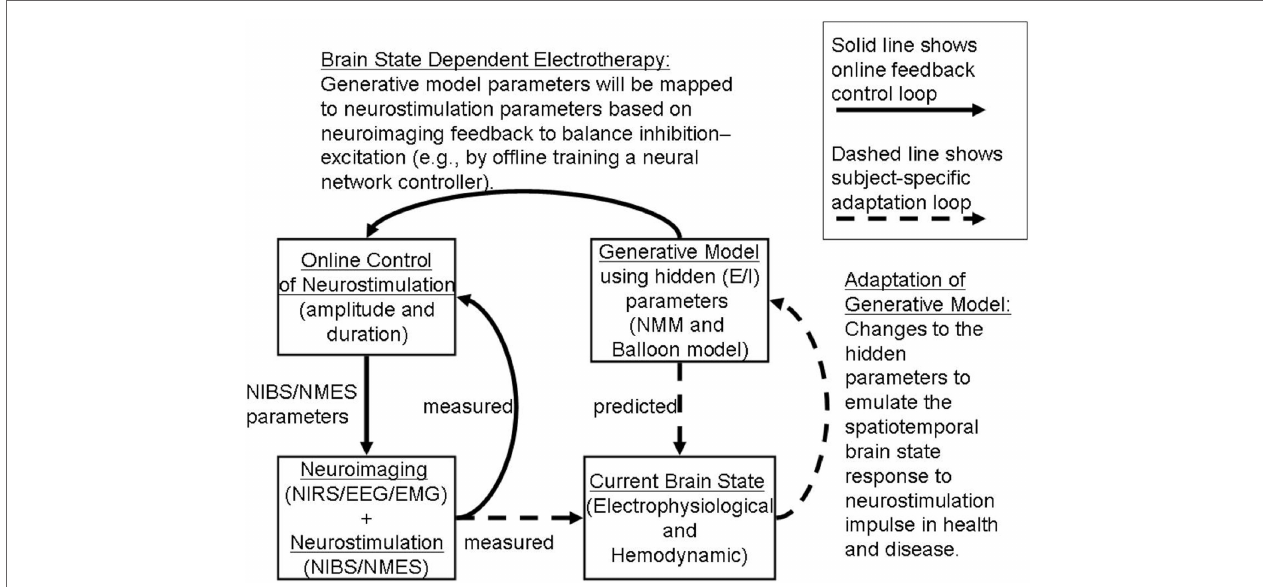
FiGUre 8 | adaptive Brain state dependent electrotherapy (Bsde) . The block diagram depicts combined recording of brain signals from fNIRS and EEG. Brain signals recorded during online tDCS convey relevant EEG and Hemodynamic parameters. This parameter set provides the current brain state. An independent block diagram is presented in the form of a neural mass model (NMM). Output neuronal signal convolved with a Balloon model to generate Hemodynamic response and EEG forward model is used as a generator of EEG activity from specific channel location where stimulation is applied. Generative model parameters are adjusted and calibrated based on the comparison between simulated and measured current brain states. Generative model estimates the predicted E/I state as shown in the block diagram. Predicted E/I states are compared with a Multilayer Neural Network (NN) model that is pre-trained offline with control signals taken from healthy and patient populations. tDCS stimulation parameters are derived in the online control module by arriving at a match between the predicted E/I and measured E/I values. This stimulation parameter values are then used for application of